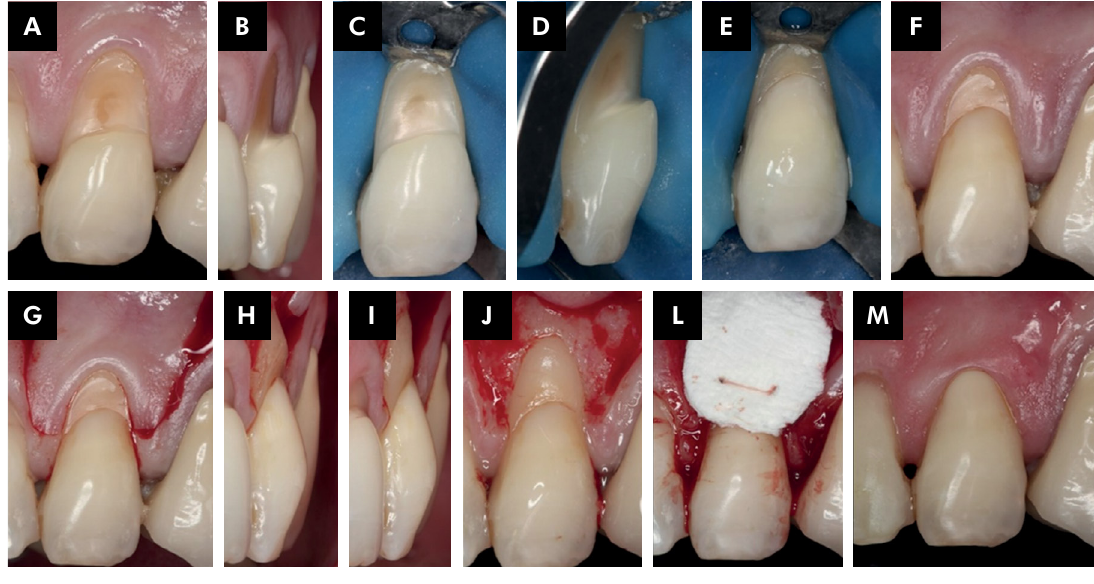
Figure 10. Representative case of a combined defect (CD) in which recession type 2 (RT2) gingival recession associated with B+ was treated with partial restoration and periodontal surgery. Buccal and lateral views of the CD (a and b); buccal and lateral views after isolation (c and d). The apical limit of the restoration was placed 1 mm apical to the estimated maximum root coverage level (e and f). Flap design (g) and lateral view of the tooth defect. Note that the apical border of the non-carious cervical lesion (h) was scaled and planed (i and j). View of the collagen matrix graft (l) and final outcome after one year